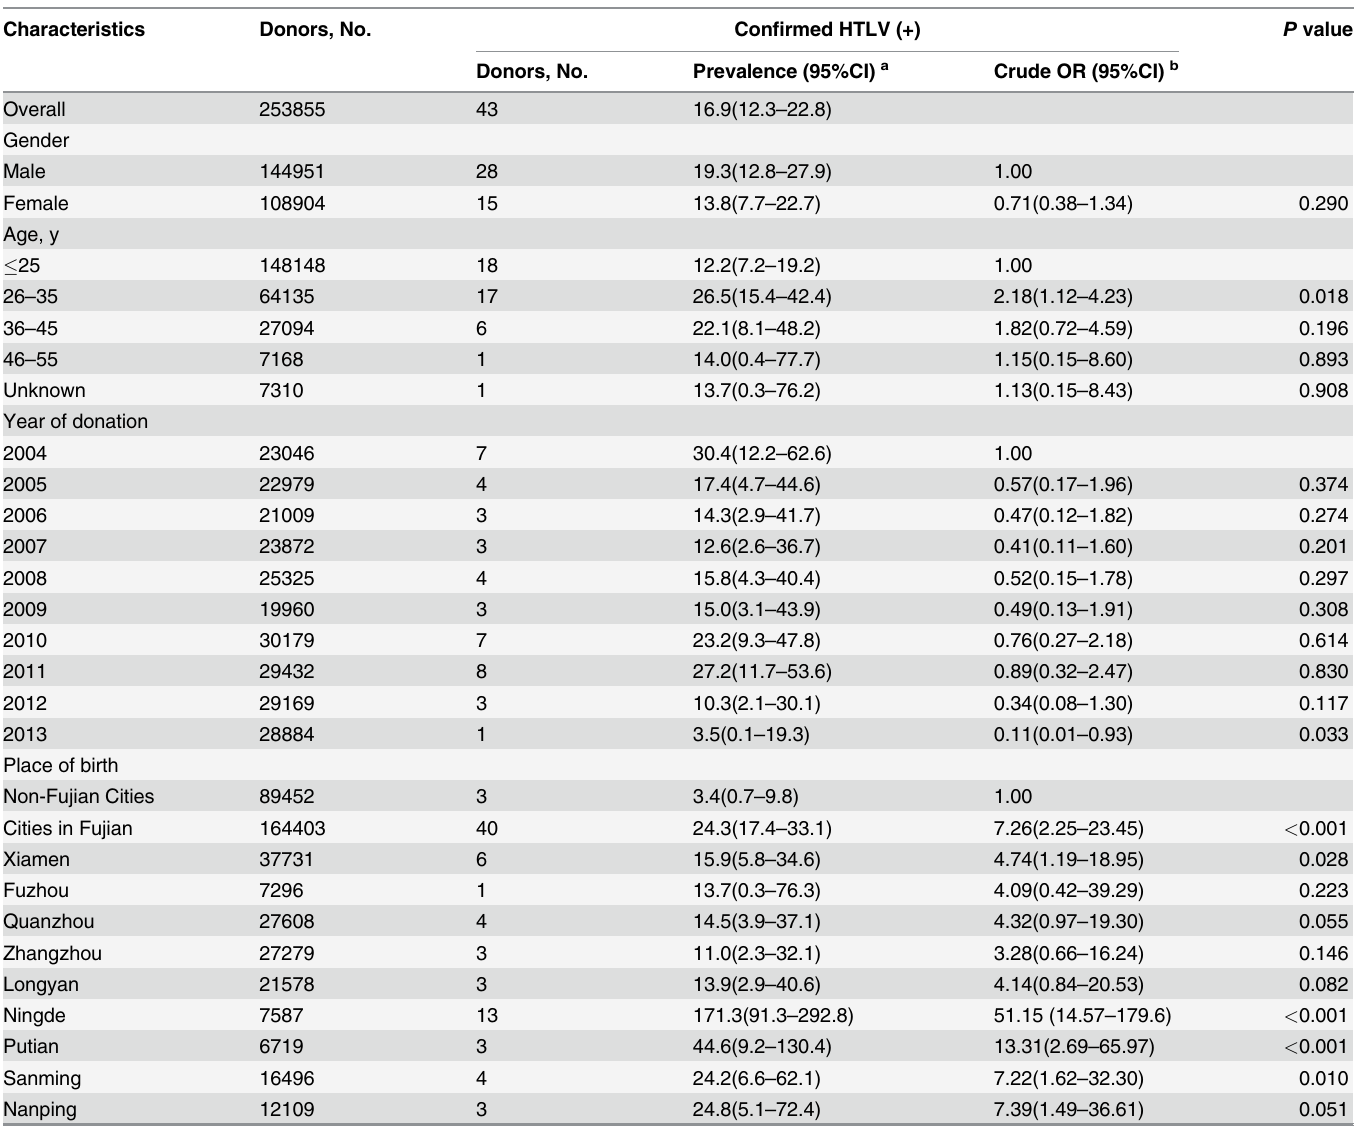
Table 2. Demographic characteristics of the